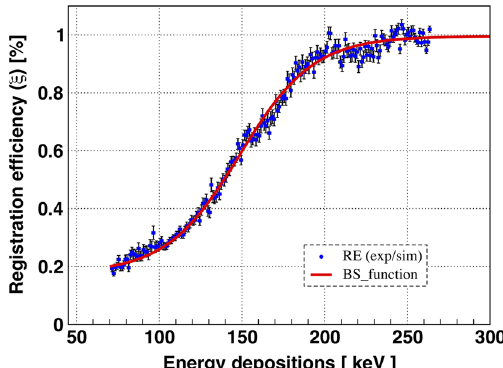
Fig. 9 Registration efficiency is shown by blue symbols as the ratio of energy depositions spectra (Exp/ Sim). The error bars indicate the statistical uncertainties. The energy range starts at 70 keV, since the simulations were performed with a threshold energy deposition of 70 keV. The red line shows the Boltzmann A A A Sigmoid Function: BSF 1 + ( 0 − 1 )/ = 0.003 represent the minimum and maximum values of BSF, respectively. A 2 represents the mean ± between the minimum and maximum values of BSF, which is 148.7 0.5 keV, while A 3 22.77 0.48 keV ± = ± indicates the slope of the function. The BSF is plotted with 3 σ standard deviations. σ is calculated using the covariance matrices as a function of the uncertainties in the values of the parameters ( A 0 ,A 1 ,A 2 ,A 3 ). E dep is the value of the energy deposition. The goodness‑of‑fit parameter ( χ 2 /ndf) is equal to